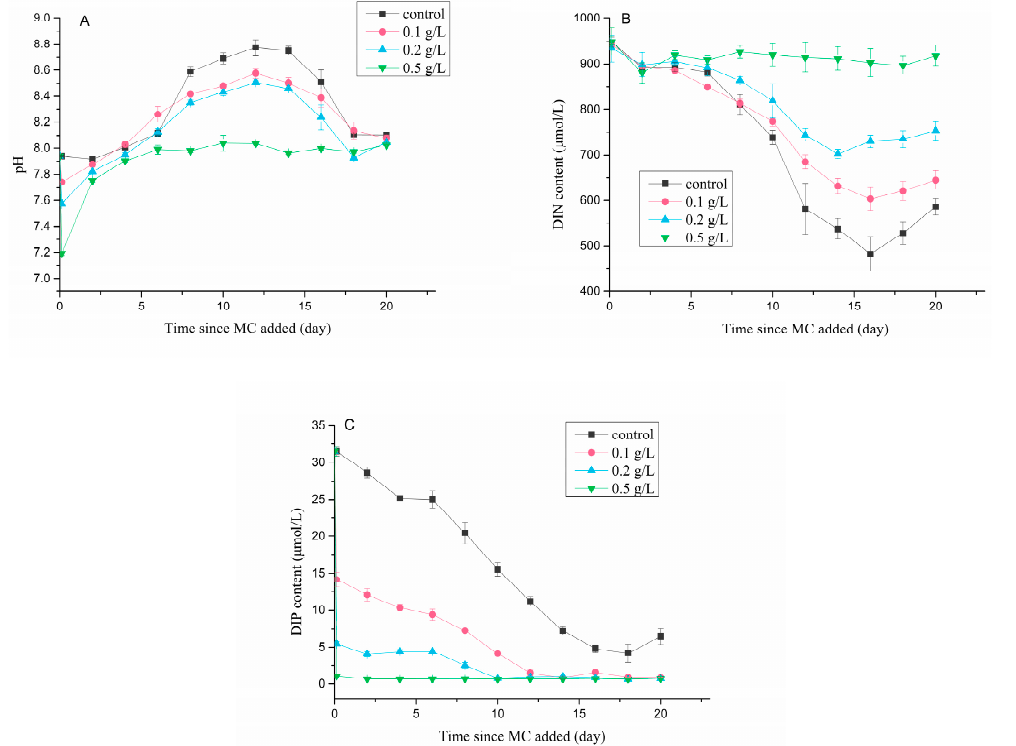
Figure 9. Changes in ( A ) pH, ( B ) DIN content and ( C ) DIP content in the P. globosa culture after MC